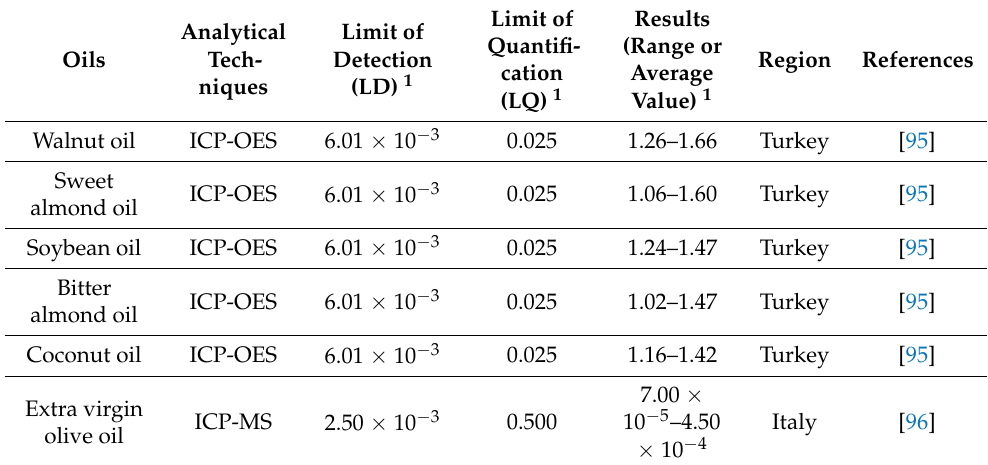
Table 7. Summary of data obtained from the presence of antimony (Sb) in edible vegetable oils.